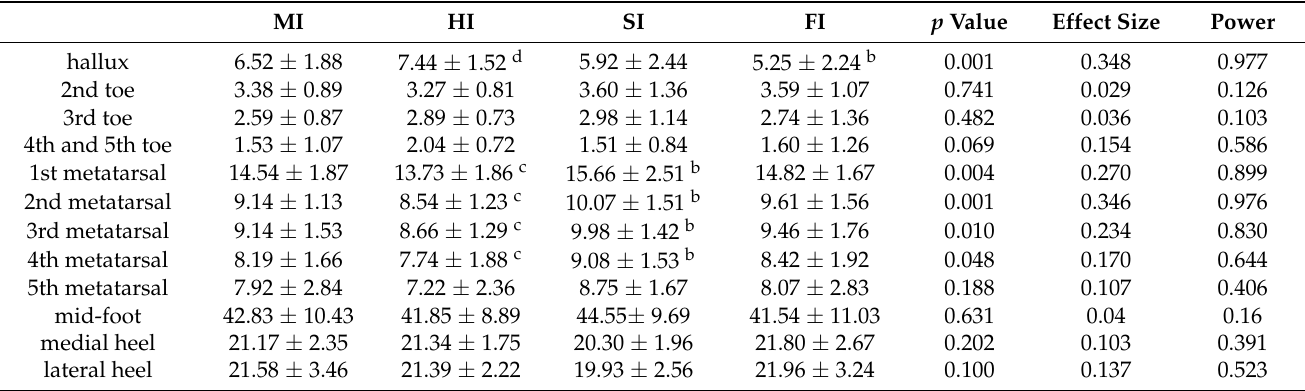
Table 5. Contact area (cm 2 ).